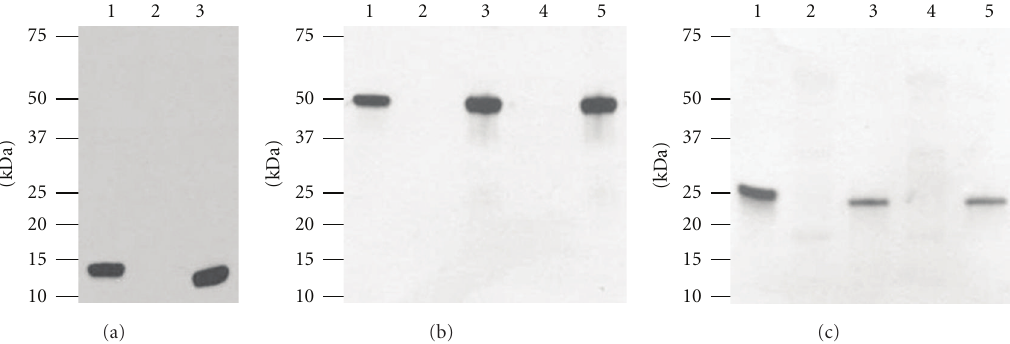
Figure 1: Western blot analysis of WNV DIII antigen and E16 mAb expression in N. benthamiana and lettuce. (a) WNV DIII. Leaf protein extracts were separated on a 4–20% SDS-PAGE gradient gel and transferred onto PVDF membranes. The membranes were probed with a rabbit anti-WNV DIII polyclonal antibody. Lane 1: E. coli- derived DIII standard; lane 2: protein extract from leaves infiltrated with bu ff er (negative control); lane 3: extract from DIII construct infiltrated N. benthamiana leaves. (b) and (c) Expression of E16. Wild-type laboratory- grown lettuce or N. benthamiana were infiltrated with dual-replicon geminiviral vector pBY-HL (hE16-no-KDEL). R and harvested on 4dpi. Total leaf protein extracts were separated on 4–20% SDS-PAGE gradient gels under reducing conditions and transferred to PVDF membranes. The membranes were incubated with a goat anti-human-gamma chain antibody to detect HC (b) or a goat anti-human-kappa chain antibody to detect LC (c). Lane 1: human IgG reference standard; lane 2: extract from lettuce leaves infiltrated with bu ff er (lettuce negative control); lane 3: protein samples from lettuce infiltrated with geminiviral vector pBY-HL(hE16-no-KDEL). R; lane 4: extract from bu ff er-infiltrated N. benthamiana leaves (negative control); Lane 5: N. benthamiana leaf protein extract infiltrated with pBY-HL(hE16-no- KDEL). R